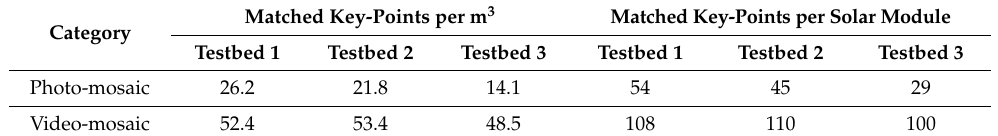
Table 3. Comparative evaluation of point cloud between the video-mosaic versus the photo-mosaic.